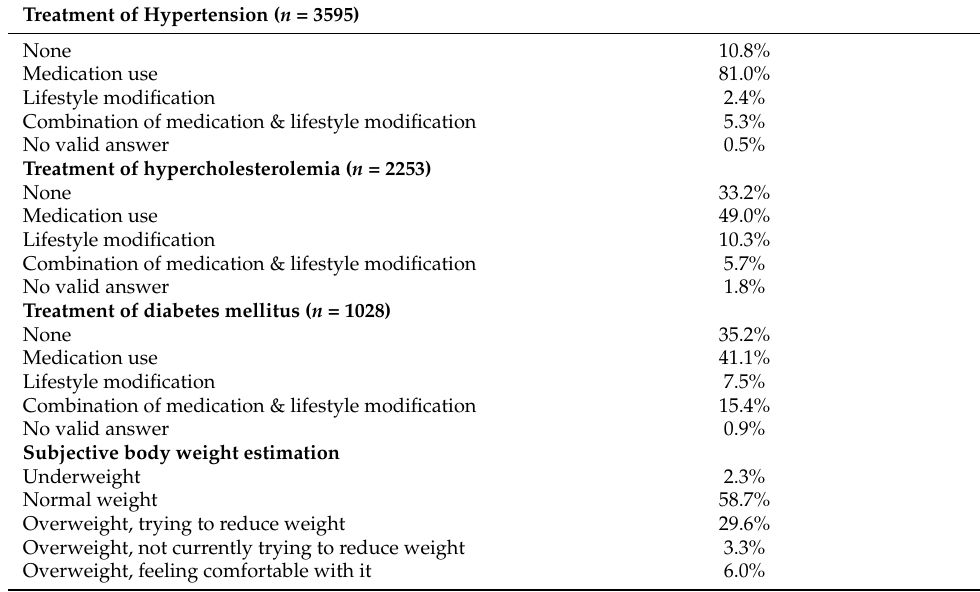
Table 2. Reported treatment of various conditions and subjective body weight estimation.